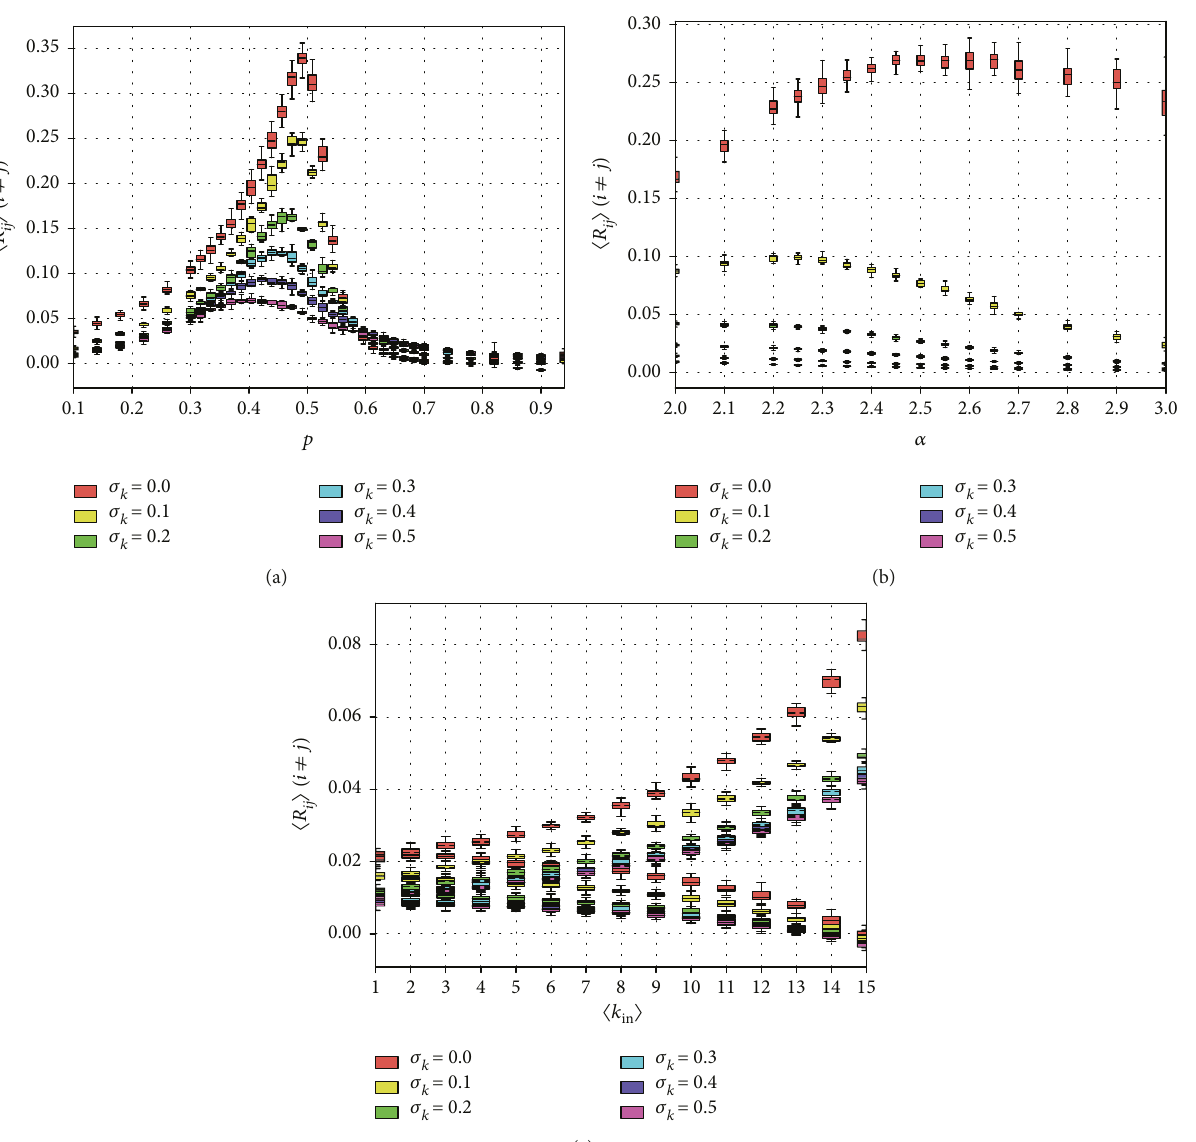
Figure 9: For model A, de fi ned in (3), the average correlation between variables, R , is plotted as a function of the characteristic network ij parameter, μ , for 3 network topologies: Erdös-Rényi of size N = 50 (a), heterogeneous network of size N = 200 (b), and Newman modular of size N = 256 and k total = 16 , where intracluster (dimmer upper) and intercluster (solid bottom) correlations are held separately (c). The account for the distribution of each value is captured by a boxplot computed from 50 independent realizations. Six di ff erent values of σ K variability of K parameter. As σ increases, R is scaled down, being the e ff ect much larger in heterogeneous networks. In the case of ER K ij grows with increasing p until metric state eventually becomes unstable, and nodes are gradually absorbed by optimal state. network, R ij Larger dispersion on K shifts the peak towards lower values of p . Conversely, for a heterogenous network, an increase on α exponent leads to more stability of metric state, although stable conditions are more fragile. Larger dispersion on K shifts the peak towards much lower values of α . Finally, in the case of Newman modular network, stability conditions of metric state, (21), are always true for these parameters and hence the absence of the peak. For a better understanding of change of stability landscape, see Figure 6. The parameters of the model are set as Figure